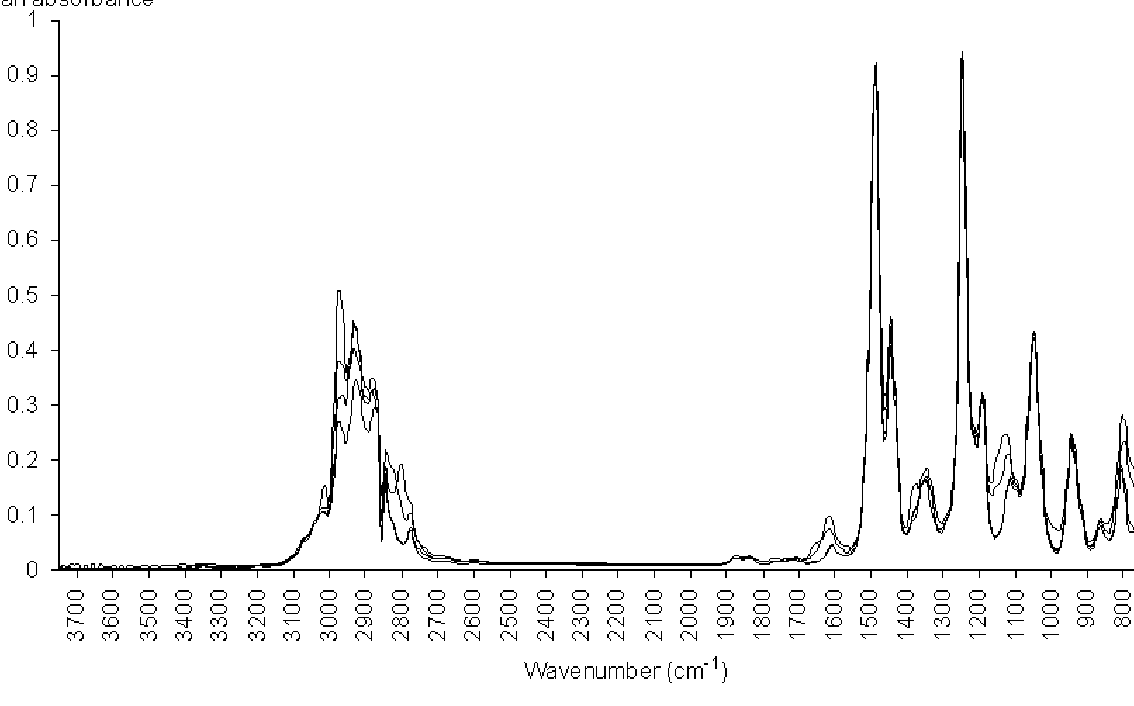
Figure 7. The GC/IR spectra of modeled hallucinogenic